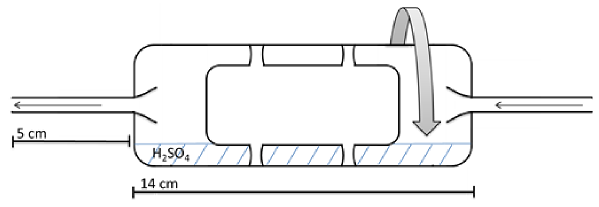
Figure 4. Schematic of the rotating sulfuric acid saturator. The sat- urator is connected to the sample tube as in Fig.